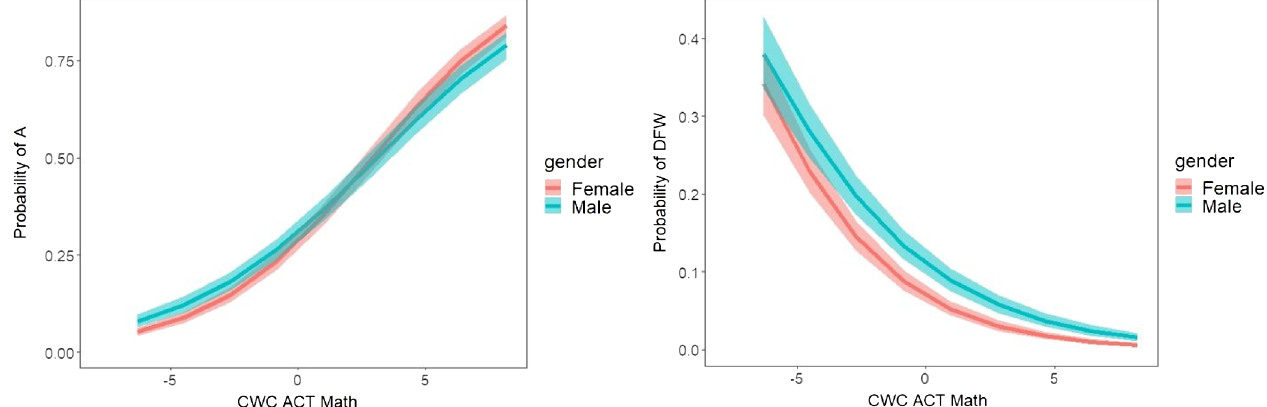
FIG. 1. Algebra-based course plots of significant interactions; probability of receiving an A vs group-centered ACT math score by gender and probability of receiving DFW vs group-centered ACT math score by gender.